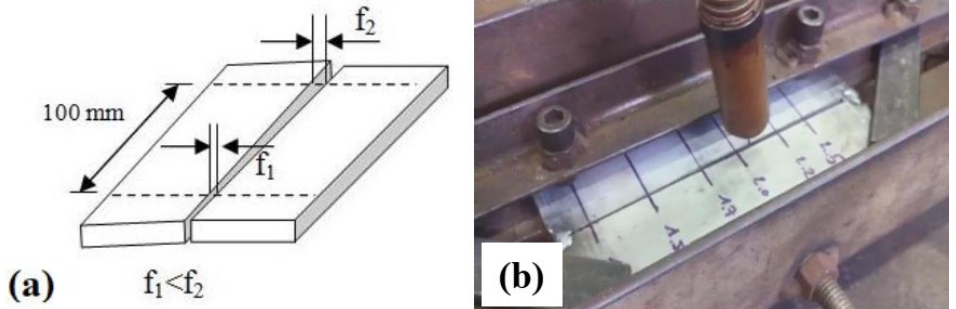
Figure 2. Test coupon showing the groove with an opening root gap: ( a ) schematic; and ( b ) in a fixture.